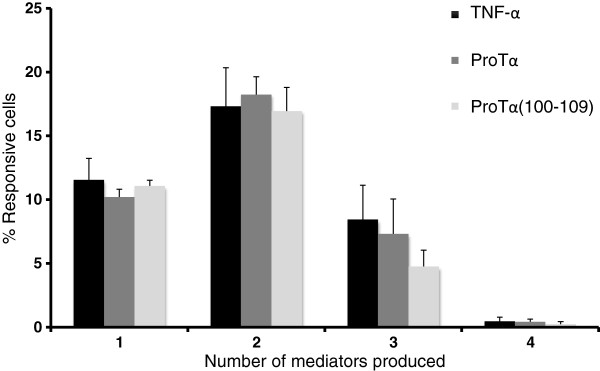
HER-2(9369)-specific T cells, stimulated with proTα- or proTα(100–109)-matured DCs, are polyfunctional. The proportion of cells producing IFN-γ, TNF-α, IL-2 or CD107a was determined in total responsive CD8+ T cells recovered from cultures stimulated with DCs matured with TNF-α, proTα or proTα(100–109). Mean ± SE of data obtained from 3 different donors are shown.